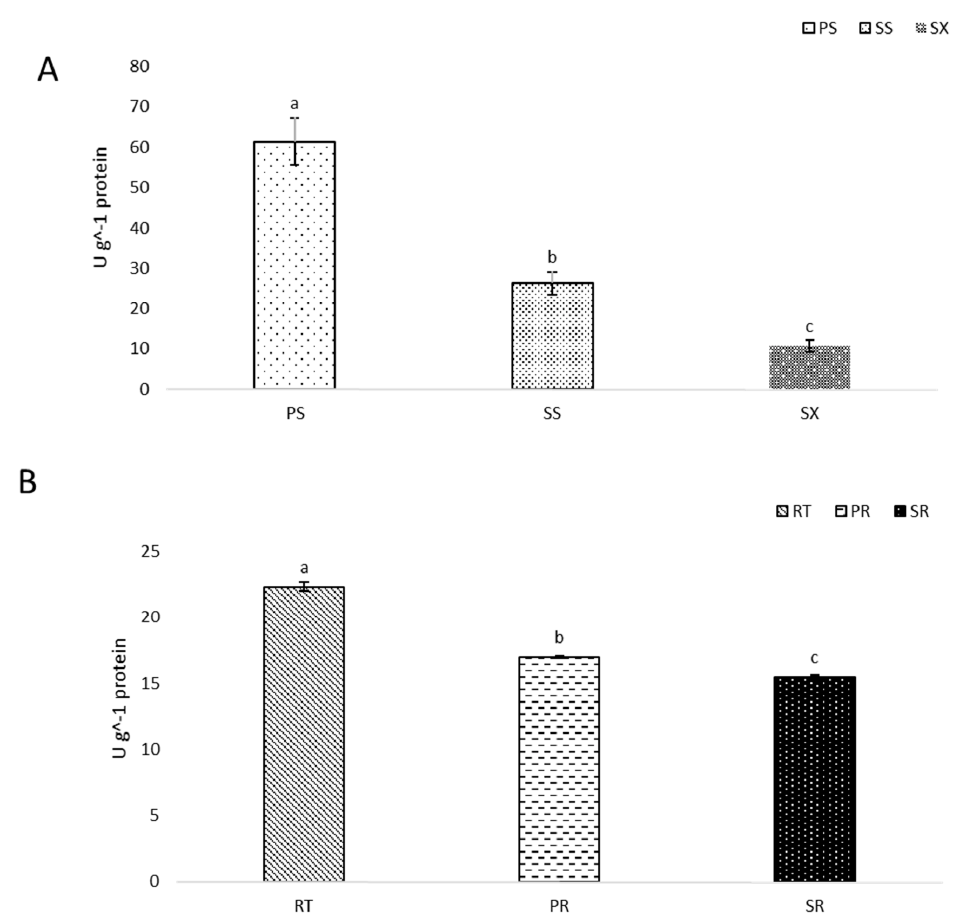
Figure 2. Superoxide dismutase (SOD) activity during the development of black cottonwood ( Populus trichocarpa ) stems ( A ) and pioneer roots ( B ): PS—stem apical meristem with stem primary